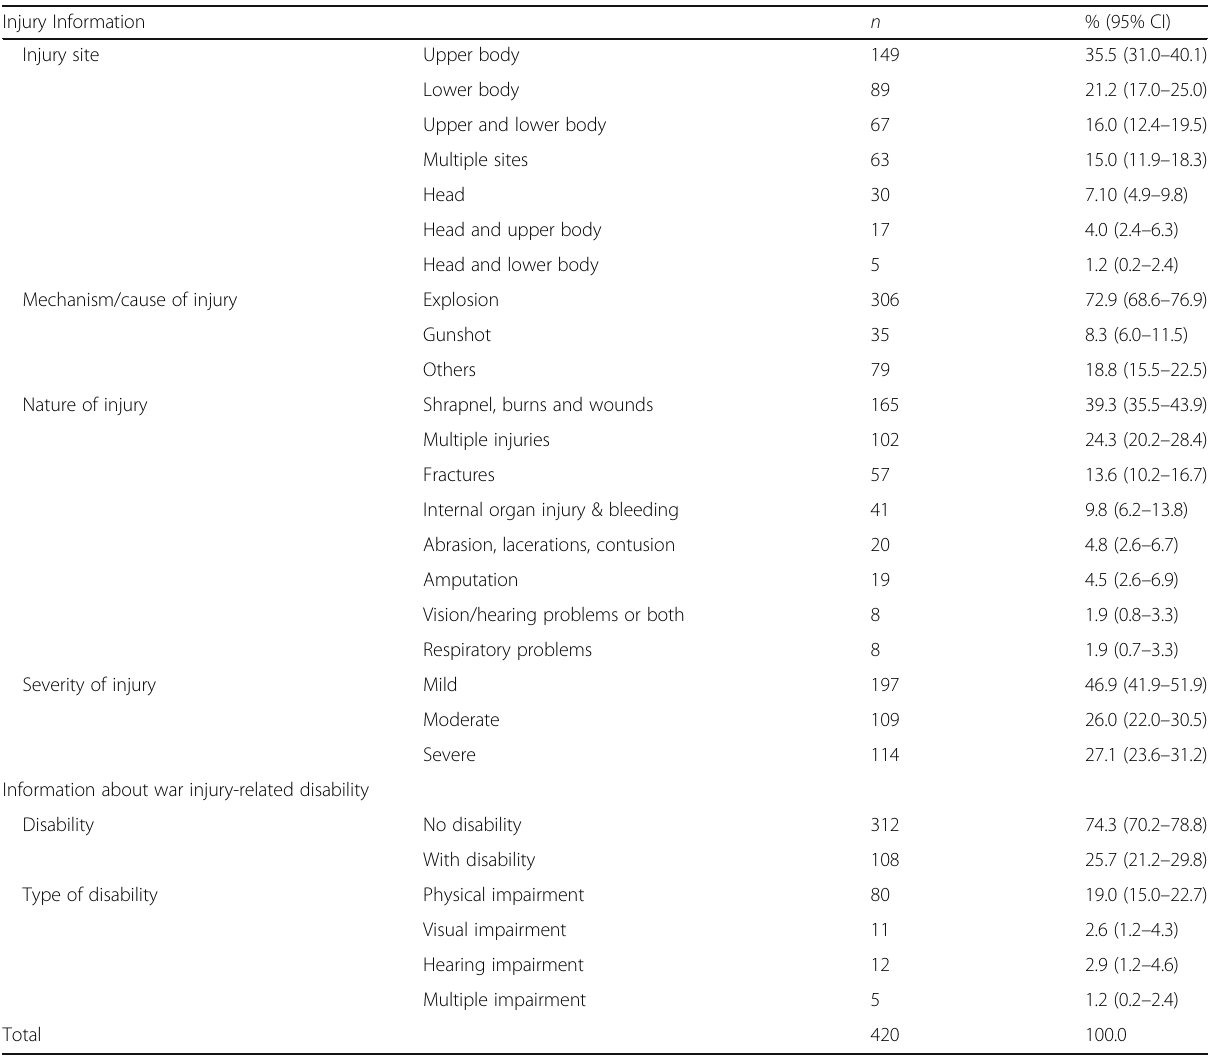
Table 3 Injury characteristics of the study sample ( n = 420) Injury